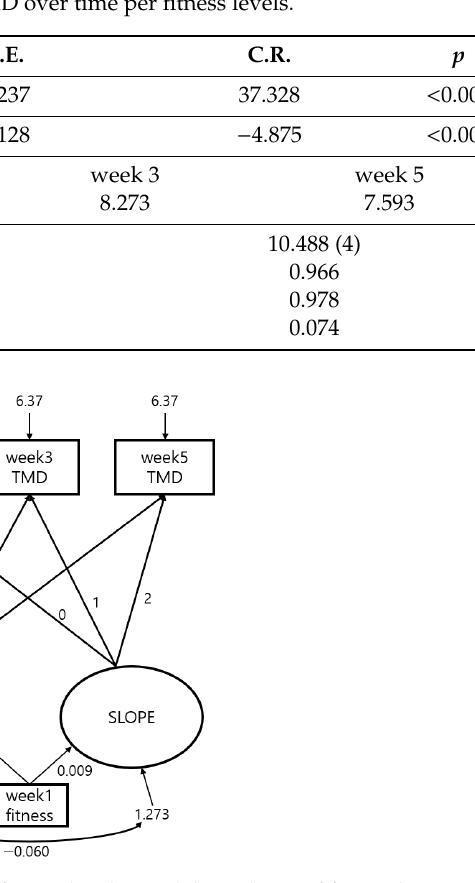
Figure 3. Changes in TMD score per fitness levels, model goodness of fit results.